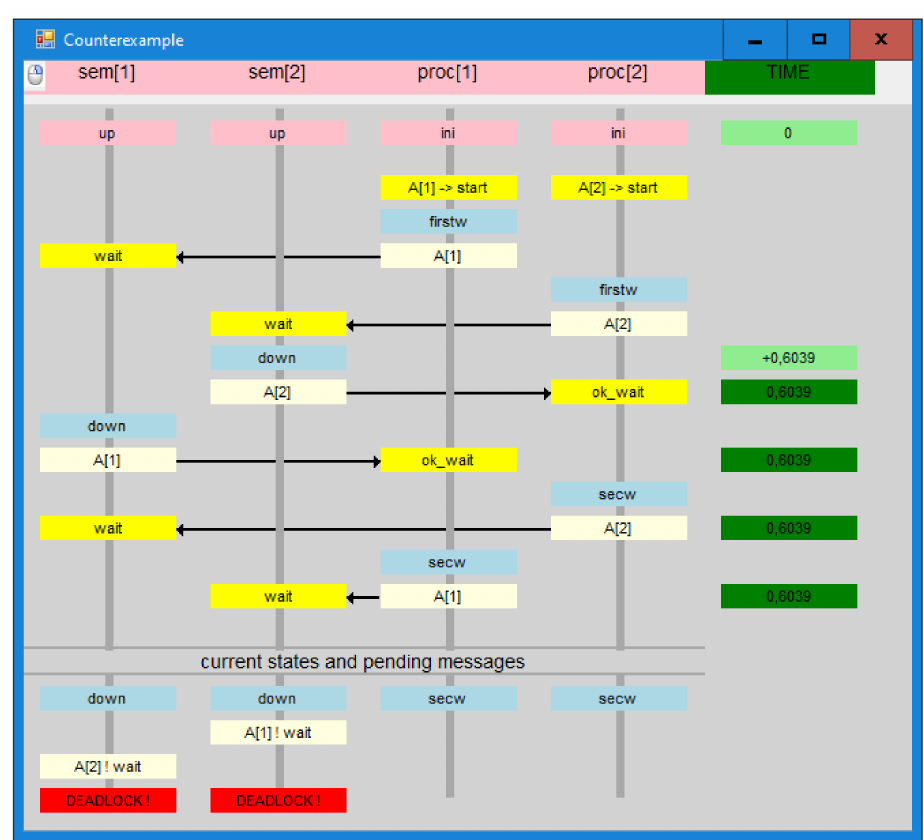
Figure 8. A counterexample showing a deadlock in the timed verification of two semaphores